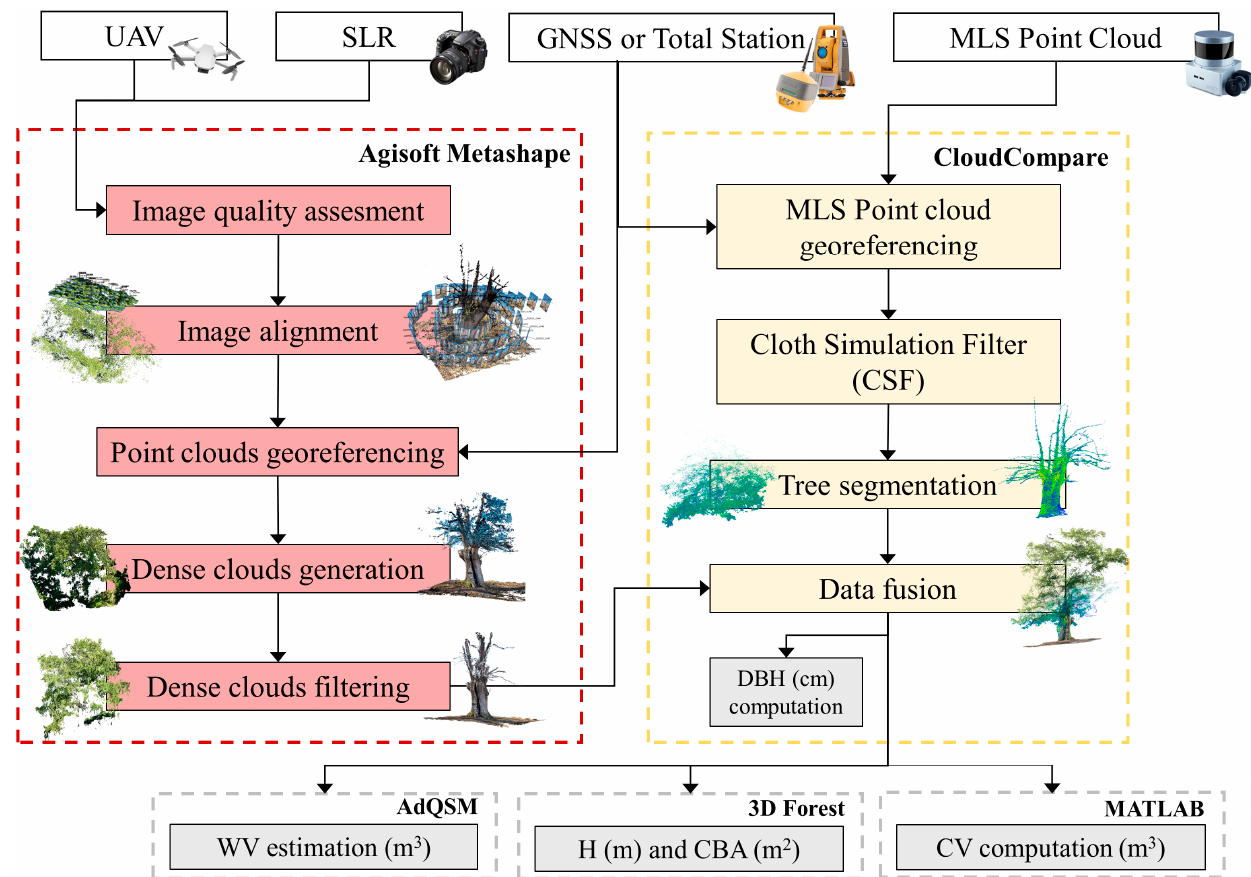
Figure 2. Complete workflow of the experiment; the data collection with passive (images) and active sensors (LiDAR) and georeferencing with GNSS or Total Station coordinates. The data processing with dedicated software produced the 3D tree models that allowed us to estimate main structural parameters (DBH = diameter at breast heigh, WV = wood volume, H = total tree height, CV = crown volume).